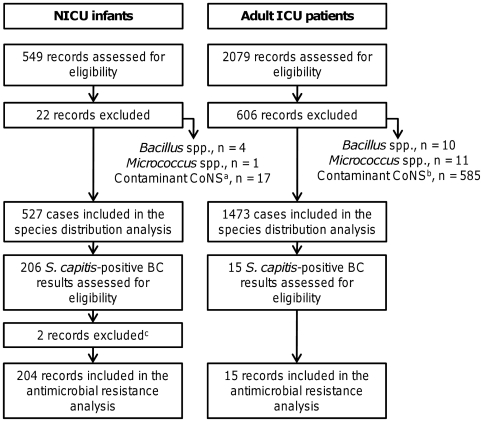
Flow diagram of case selection.(N)ICU, (neonatal) intensive care unit; CoNS, coagulase-negative staphylococci; BC, blood culture. aIn NICU infants, a single CoNS-positive blood culture was interpreted as possible bacteremia and included in the analysis. The CoNS-positive results that were excluded were explicitly recorded as a contaminant in the microbiology record. bIn adult patients, a single CoNS-positive blood culture was interpreted as a contaminant and excluded from the analysis. cRecords were excluded when antimicrobial susceptibility results were not available.